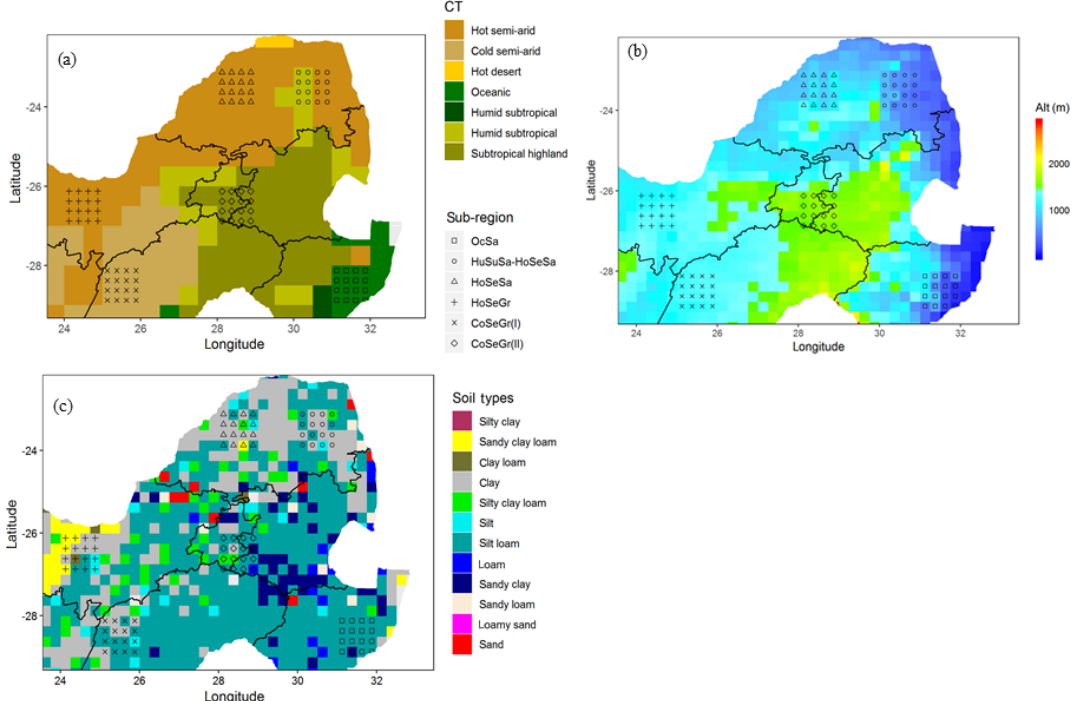
Figure 2. (a) Köppen–Geiger climate types (CT) across the study region at a 50km resolution (http://koeppen-geiger.vu-wien.ac.at/present. htm, last access: 14 December 2019). Sub-regions are selected based on homogeneous climate types and named based on the vegeta- tion and climate types, such as oceanic savanna (OceaSa), humid subtropical and hot semi-arid savanna (HuSuSa-HoSeSa); hot semi-arid savanna (HoSeSa), hot semi-arid grassland (HoSeGr) and cold semi-arid grassland (CoSeGr); (b) altitude (Alt, m) at the study region at a 25km resolution (https://www.ngdc.noaa.gov/mgg/fliers/06mgg01.html, last access: 14 December 2019); and (c) dominant soil types (https://soilgrids.org, last access: 14 December 2019) per grid cell, at a resolution of